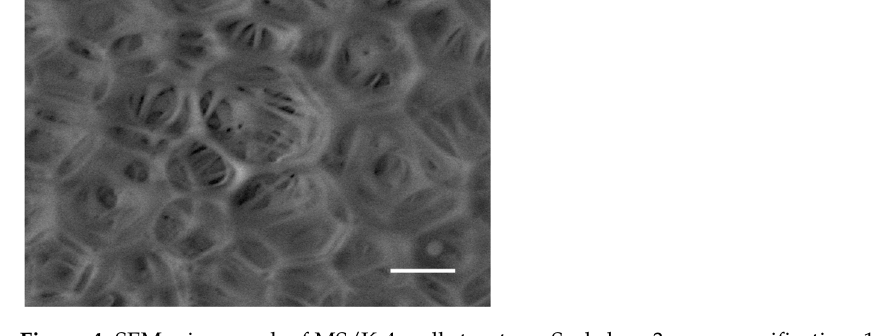
Figure 4. SEM micrograph of MS/K-4 wall structure. Scale bar: 3 µm; magnification: 13,000×.